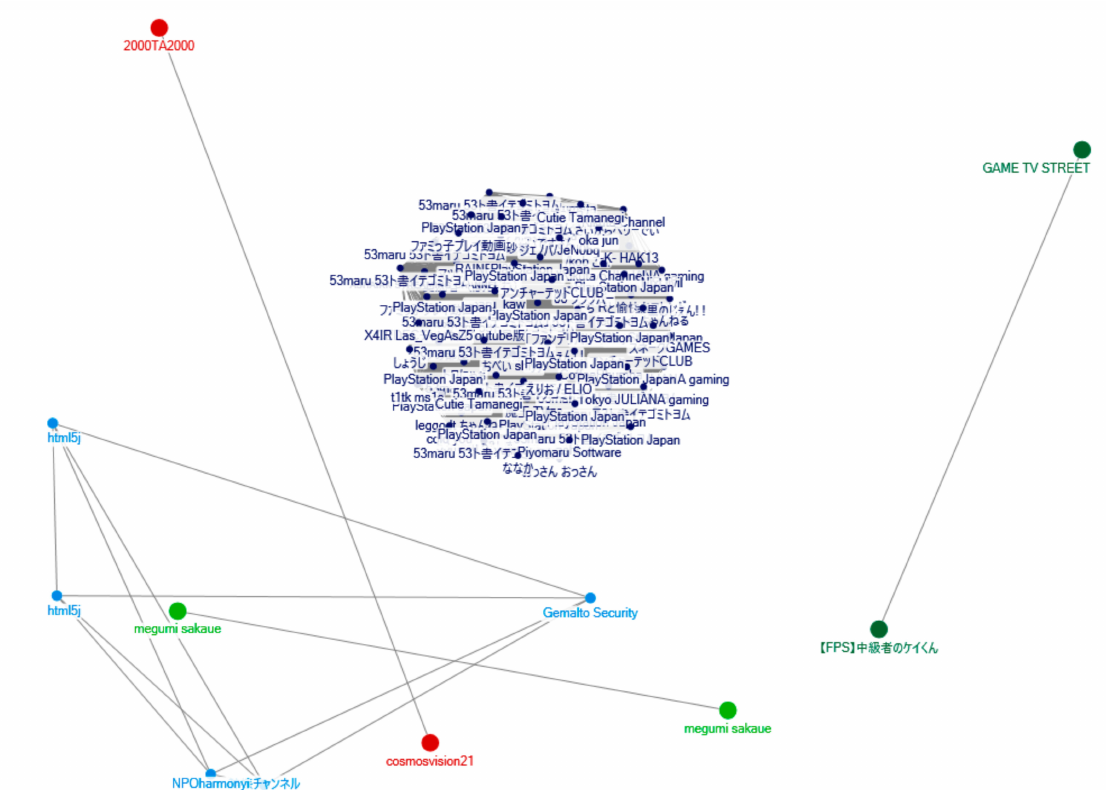
Figure 3. Node XL network regarding the accessibility of the PlayStation ®